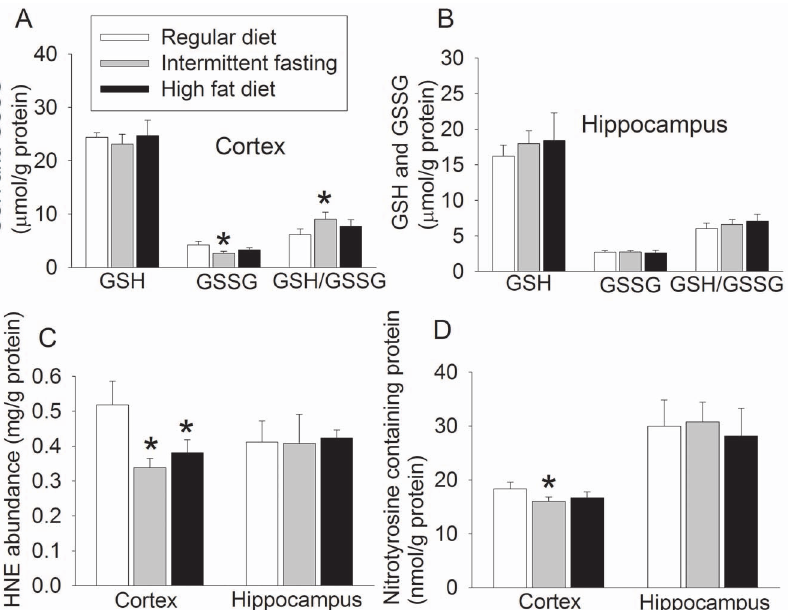
Figure 4. The effects of various feeding protocols on oxidative stress status in the brain. Seven-week old male mice had free access to regular chow or high fat diet or were allowed to have free access to regular chow every other day (intermittent fasting) for 11 months. Their brains were then harvested to measure glutathione (GSH), glutathione disulfide (GSSG), 4-hydroxy-2-nonenal (HNE) and nitrotyrosine containing proteins. The levels of GSH and GSSG and ratio of GSH/GSSG in the cerebral cortex and hippocampus are presented in panels A and B, respectively. The levels of HNE and nitrotyrosine containing proteins in the cerebral cortex and hippocampus are shown in the panels C and D. Results are means 6 S.E.M (n=8). * P , 0.05 compared with mice on regular chow ad libitum